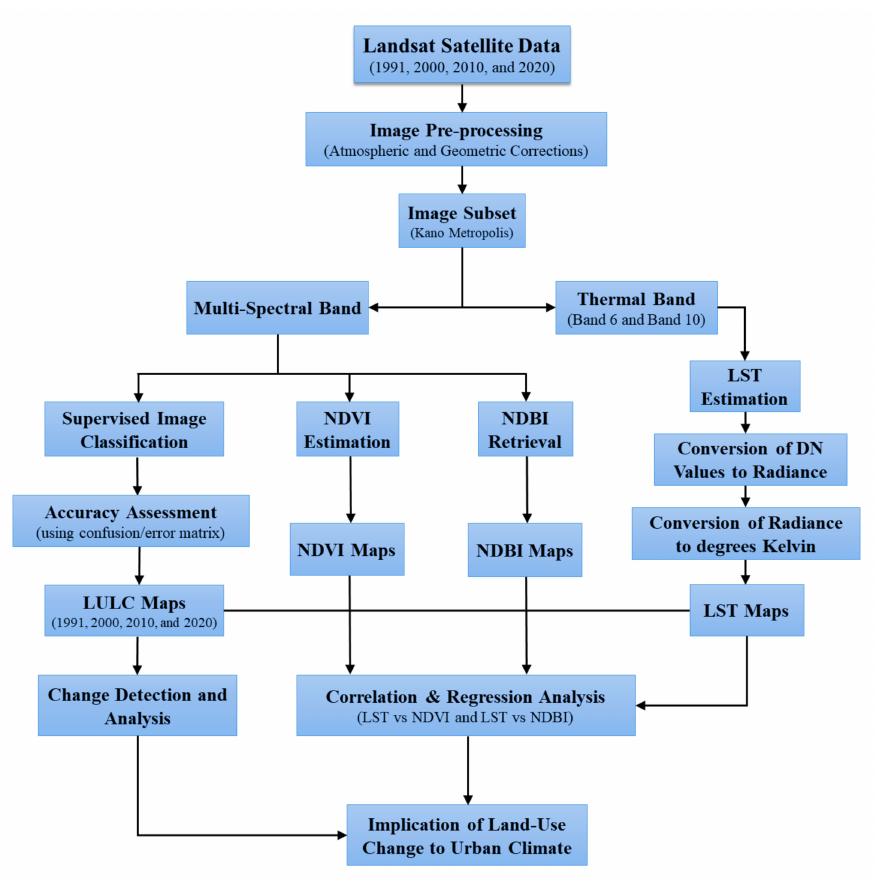
Figure 2. Methodological flowchart of the